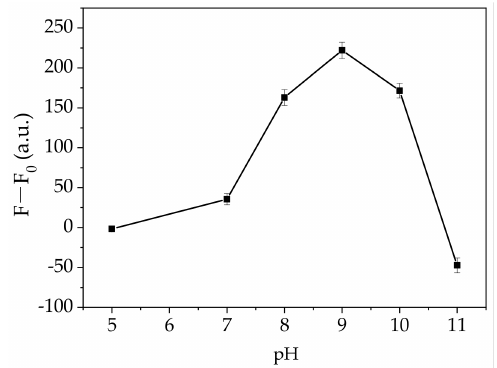
Figure 8. Effect of the pH value on Pb 2+